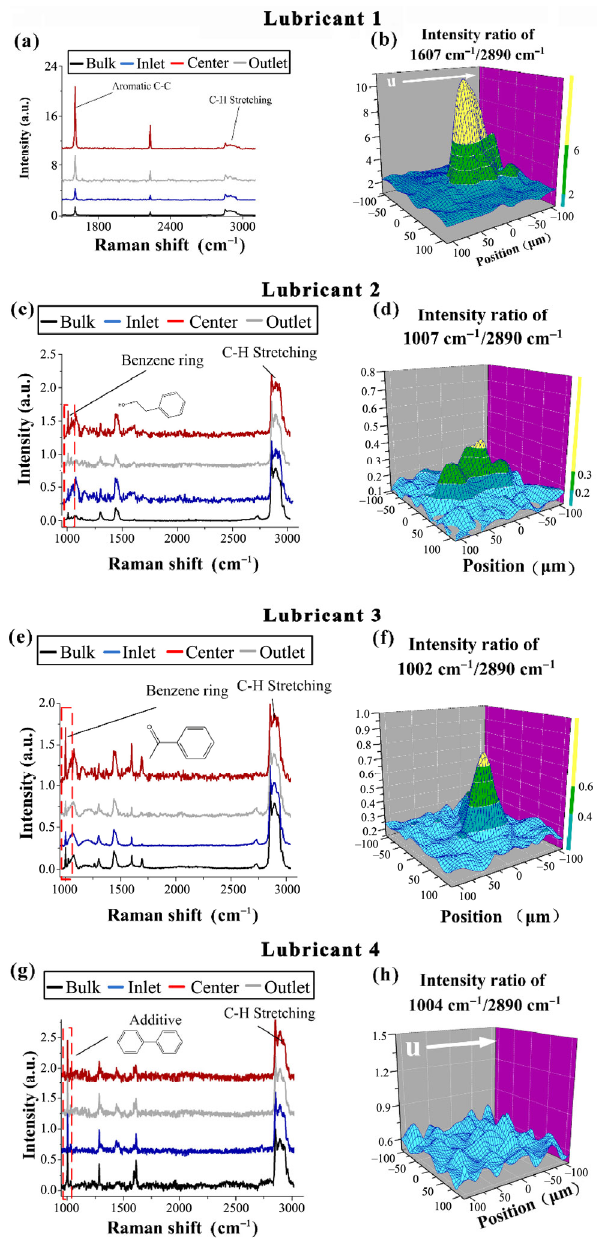
Fig. 3 Molecular distribution of Lubricant 1 − 4. (a), (c), (e), and (g): in situ Raman spectral results at the four areas and the molecular structures of two components; (b), (d), (e), and (h): in situ profile of the intensity ratio of the additive molecule to the base